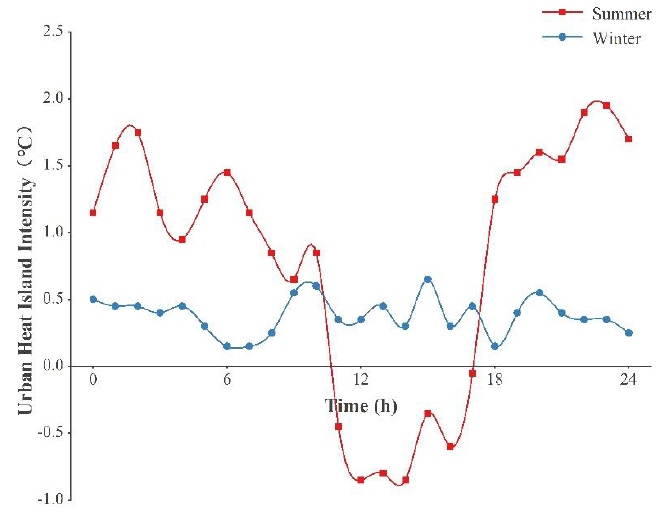
Figure 6. Typical daily heat island